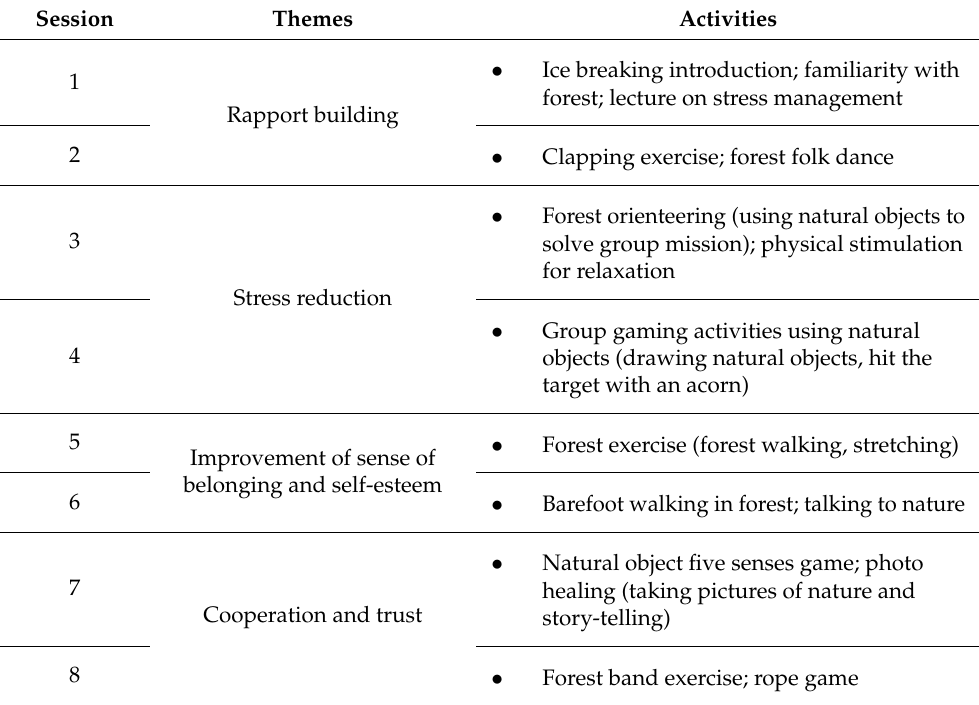
Table 1. Themes and activities of the guided forest therapy